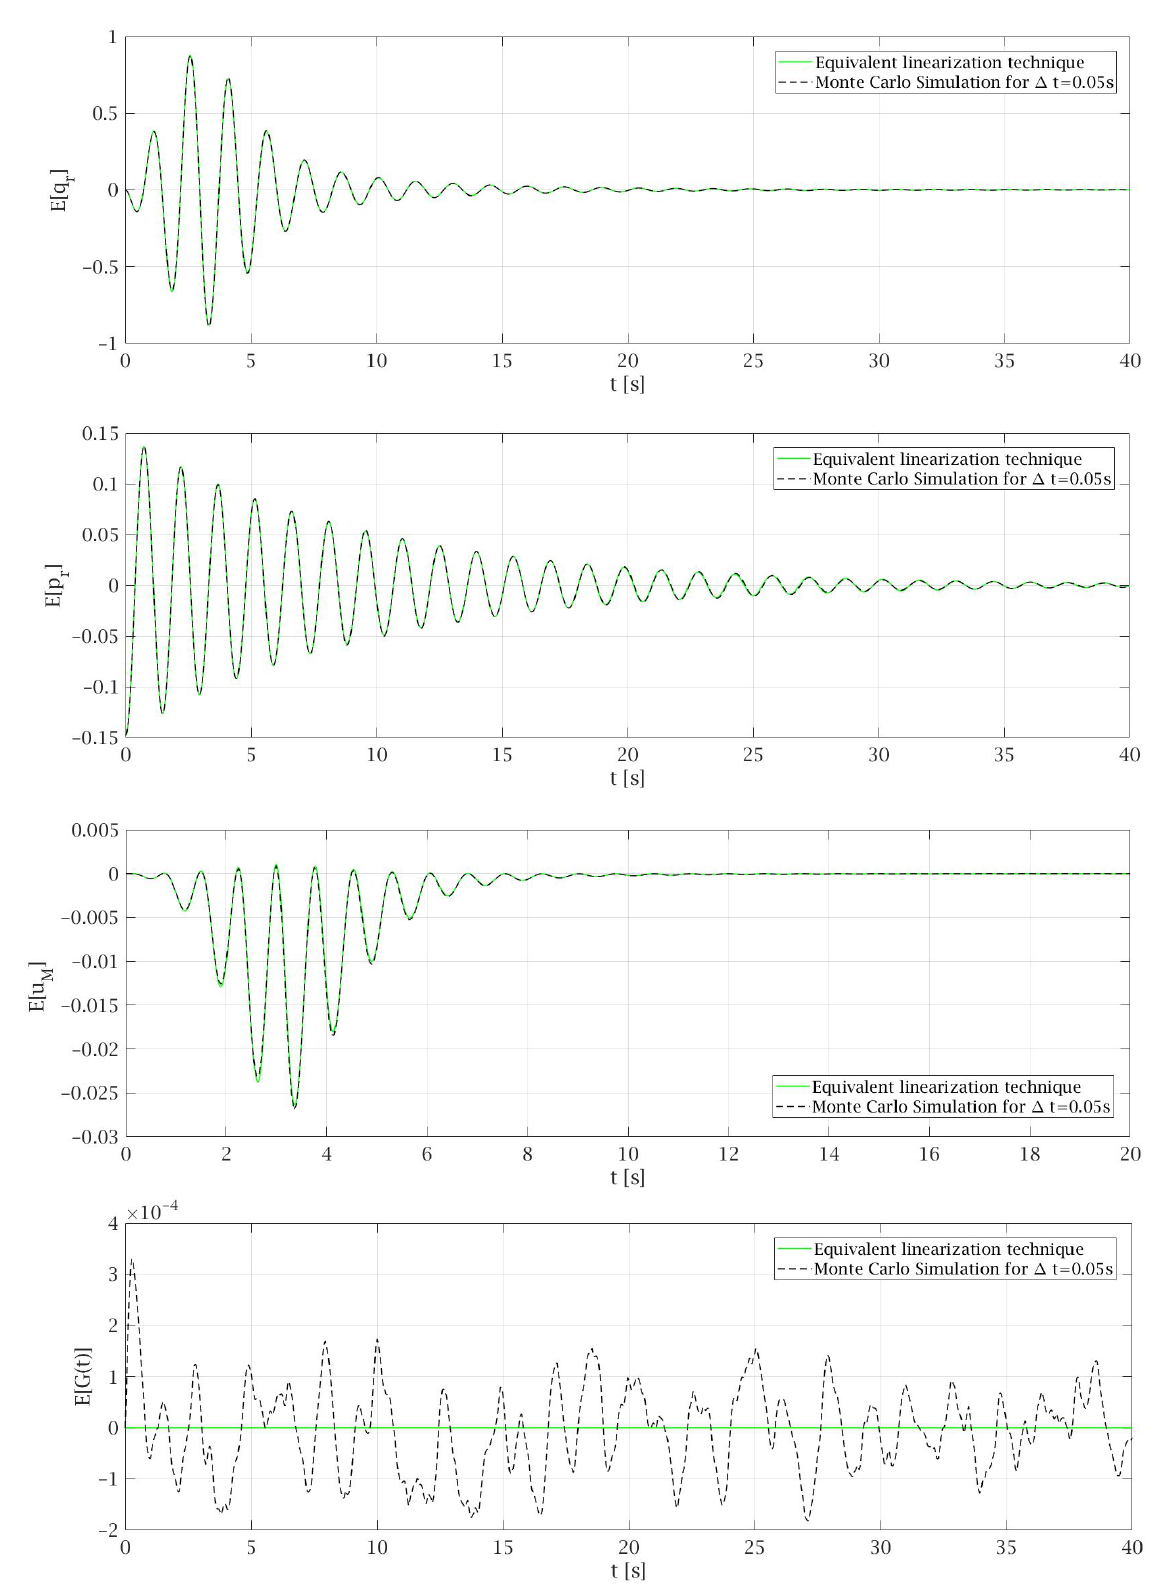
Figure 5. Comparison of the expected values of selected random state variables obtained for P = 1.87 × 10 − 4 and ζ s =